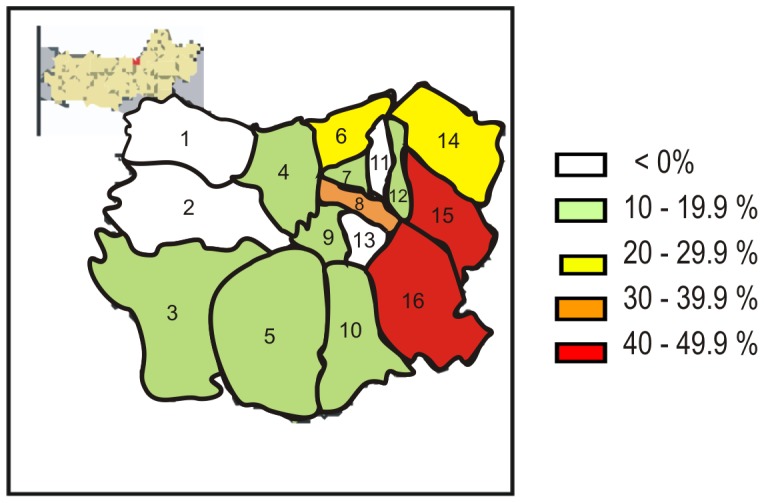
Distribution of nasopharyngeal carriage of S. pneumoniaei among healty population in the districts of Semarang, Indonesia.